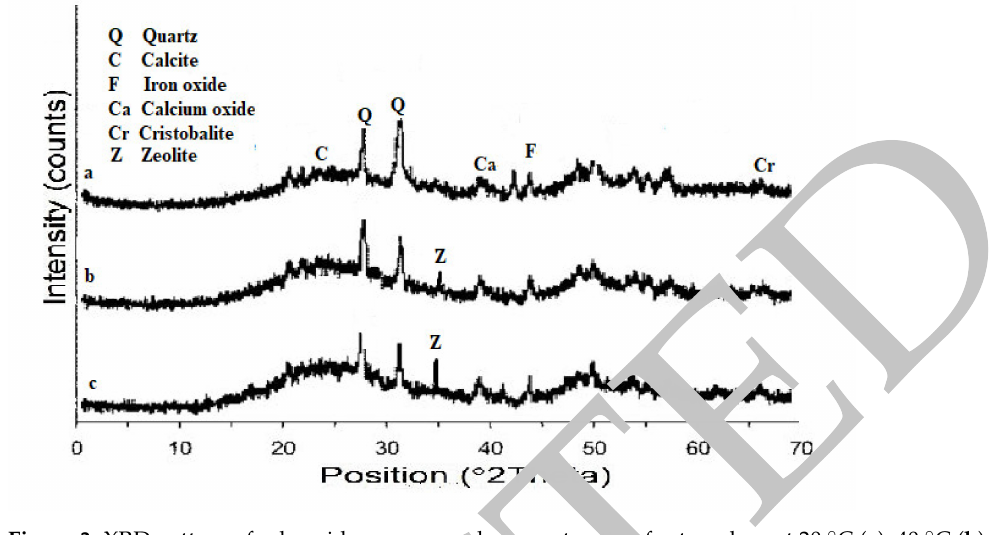
Figure 3. XRD pattern of ash residues recovered after extraction for two days at 20 ◦ C ( a ), 40 ◦ C ( b ), and 100 ◦ C ( c ).